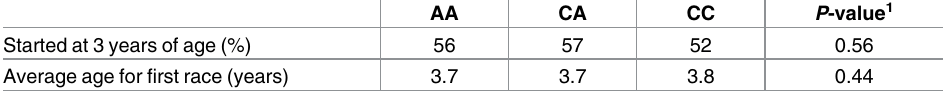
Table 1. The percentage of raced Coldblooded trotters that started their first race at 3 years of age, and the averageage for the first start, presented for each DMRT3